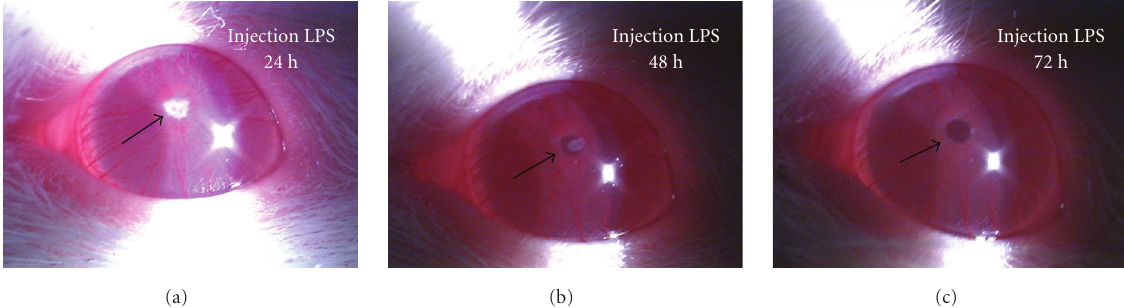
Figure 1: Clinical manifestation of EIU: (a) The image shows the eye 24 h after the LPS injection. Note the fibrinous pupillary membrane (arrow). (b) The image shows the eye 48h after the LPS injection. The fibrinous pupillary membrane has not been all absorbed (arrow). (c) The image shows the eye 72h after the LPS injection. The fibrinous pupillary membrane has been absorbed